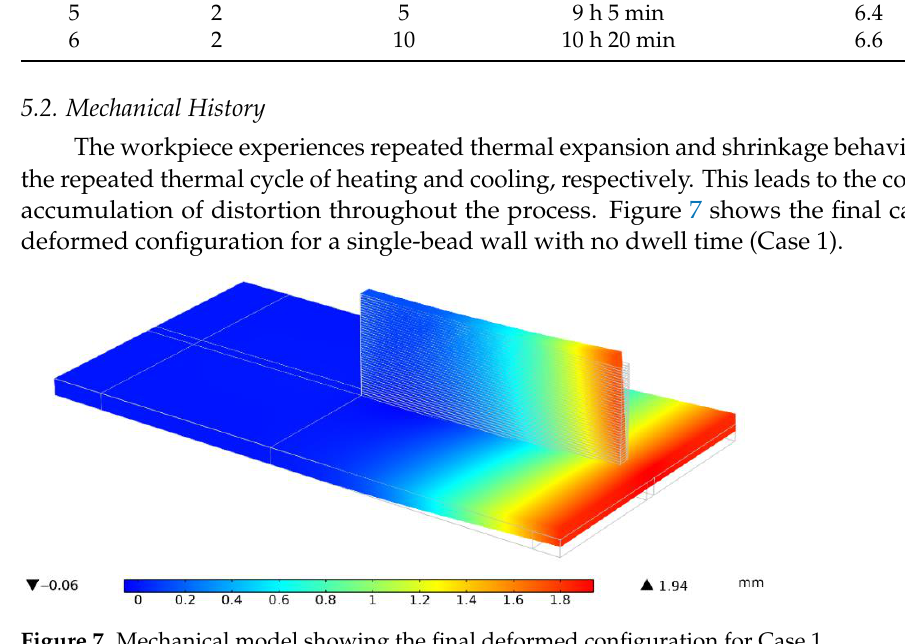
Figure 7. Mechanical model showing the final deformed configuration for Case 1.